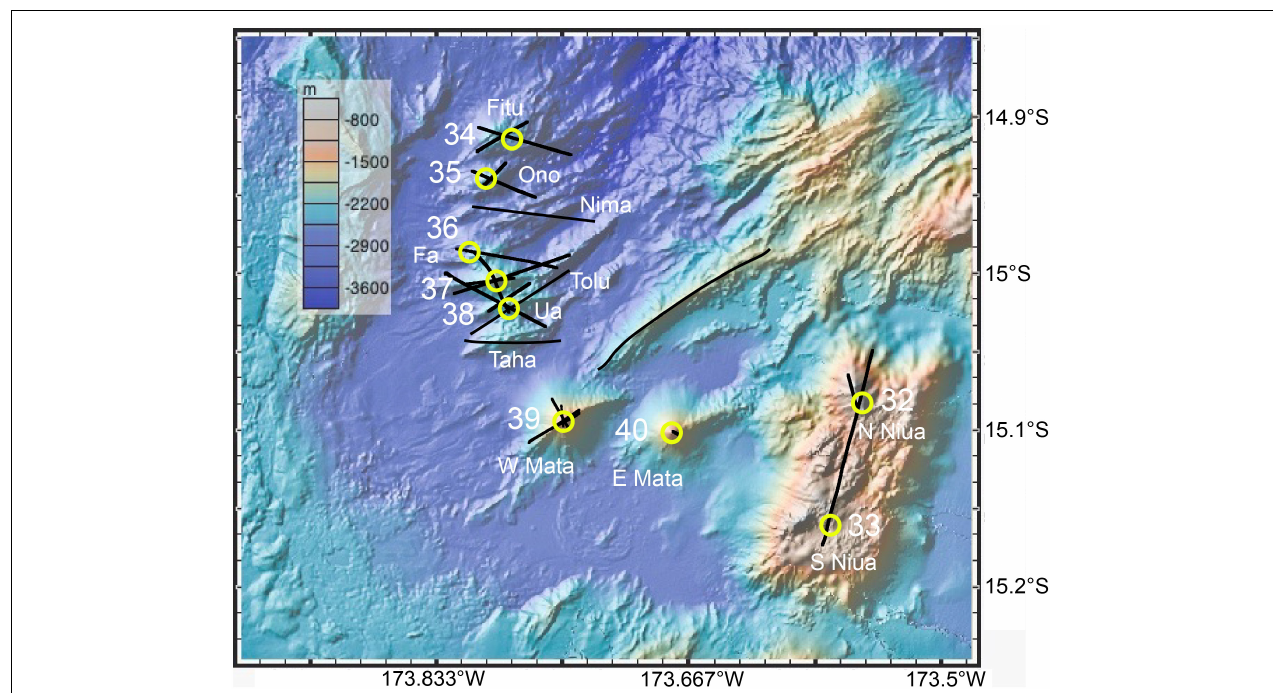
FIGURE 4 | Survey tow lines (black) and active hydrothermal sites (yellow circles) of the Matas and Niua. Numbers correspond to sites in Table 2 . Figure made with GeoMapApp